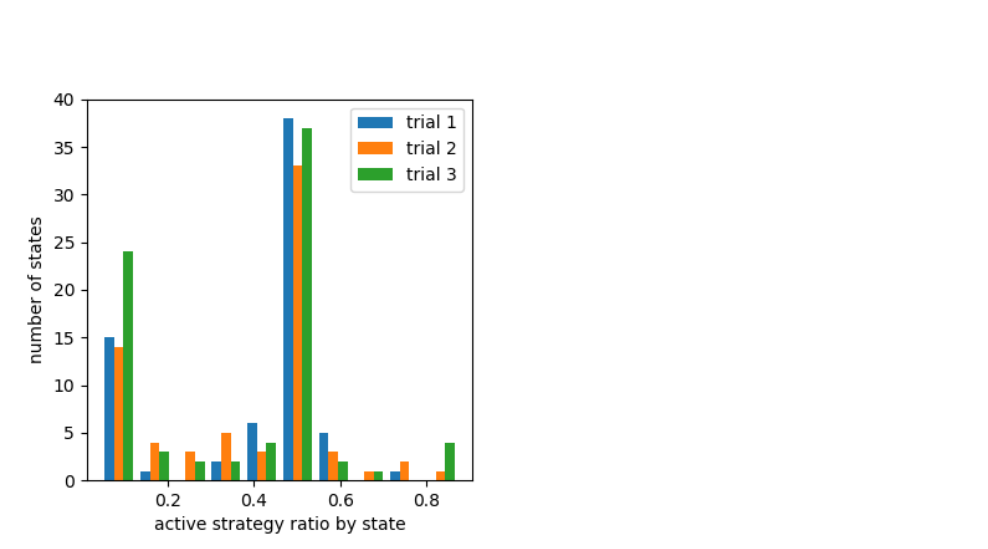
Figure 9. Percentage of active strategies chosen by state (cooperative rewards (2, 1), after passive strategy is effective).